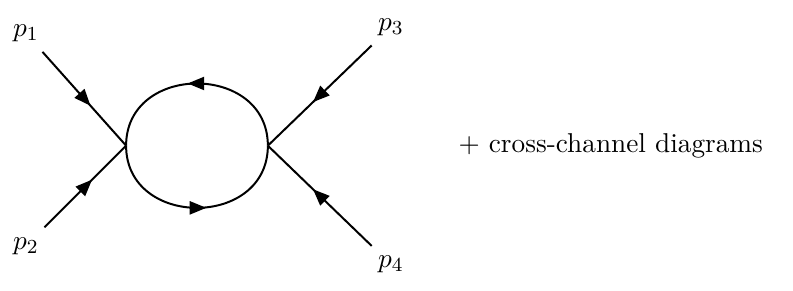
Figure 2 . One loop diagram’s. Cross-channel corresponds to two other channel of